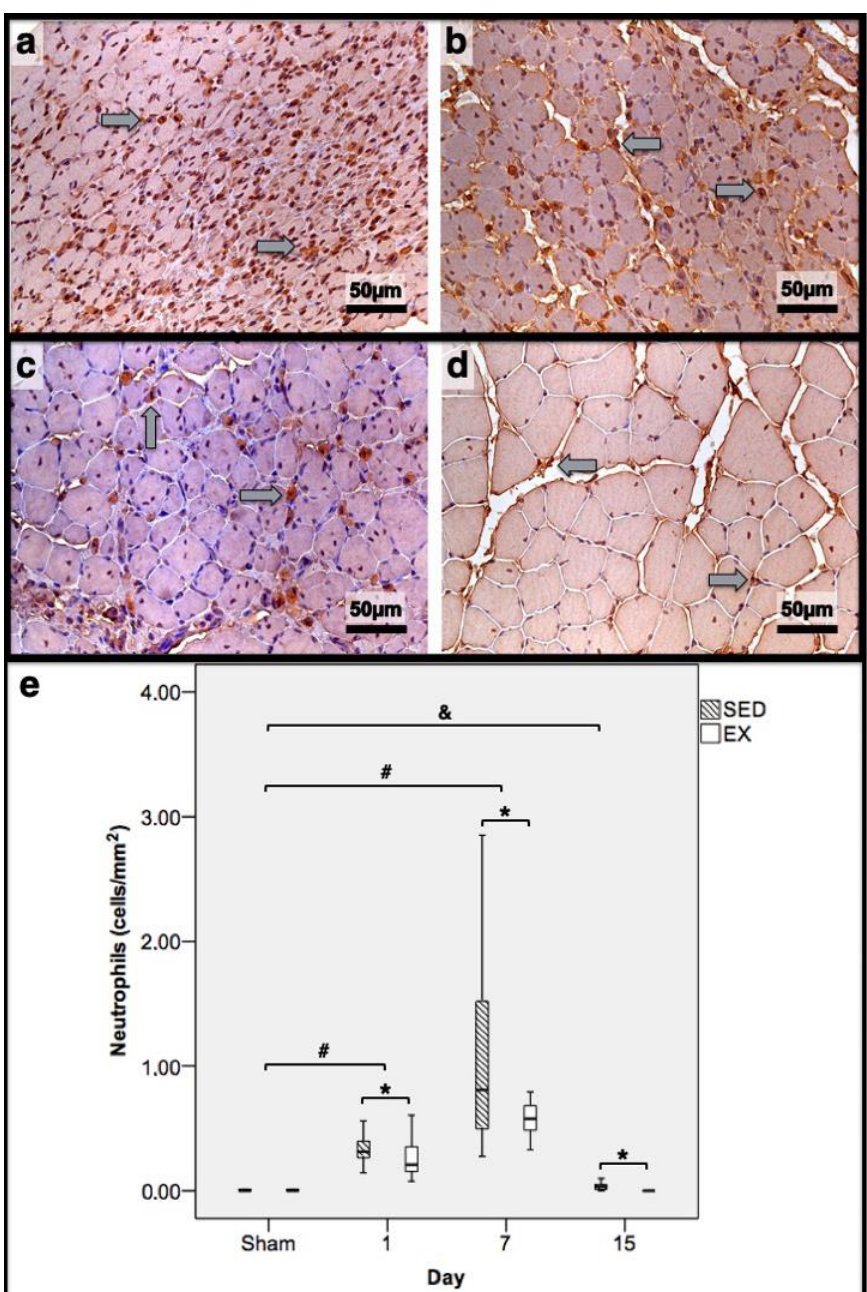
Figure 5. Immunohistochemistry of cells expressing neutrophil elastase in the tibial anterior muscles from exercise (EX: ( a , c )) and sedentary (SED: ( b , d )) groups injected with cardiotoxin, sacrificed on the 7th and 15th day post-injection (( a , b )and ( c , d ), respectively), and corresponding quantitative analyses ( e ) in all assessed days in both groups (Sham: overall median values of control muscles). Sham mus- cles in both EX and SED, injected with saline solution, represent the overall values obtained on the 1st day post-injection. The images clearly show the brown-stained neutrophil (grey arrows) infiltration, which is more pronounced in the SED group ( b , d ). Box = median, 25 to 75%; T-bars = minimum and maximum values. * significantly higher than the EX group ( p < 0.01); # significantly higher than the Sham muscles ( p < 0.01); & SED group significantly higher than the Sham muscles ( p <